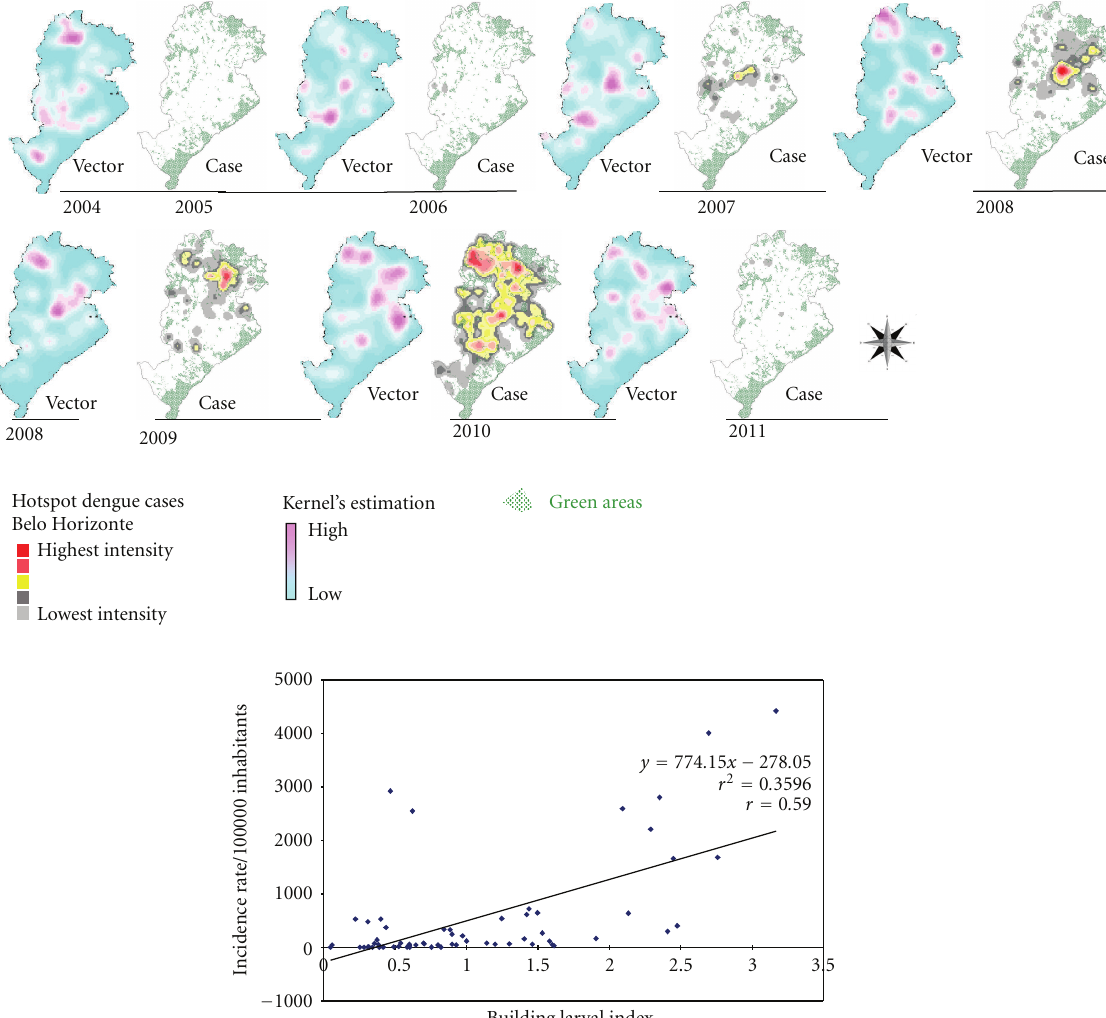
calculate the Pearson correlations and Kernel’s estimation. Excel 2003 was used to generate tables and